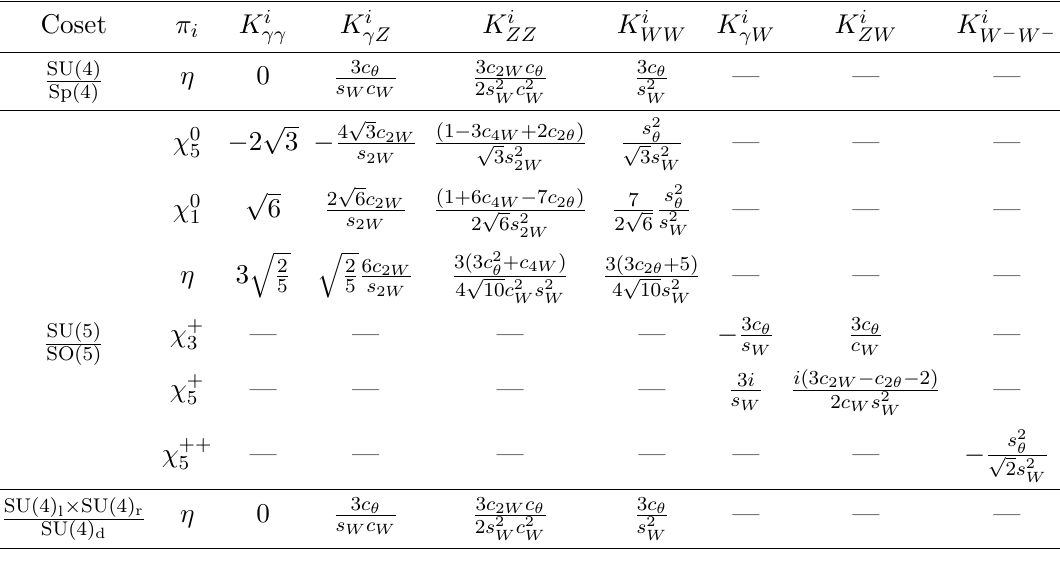
Table 1 . Coefficients of the anomaly terms in eq. (2.7) uniformly normalized by a factor e 2 dim( ψ ) Here η always denotes a SM singlet while the remaining coefficients are expressed in the custodial basis but otherwise agree with those in [10]. The pNGBs not appearing in the table do not couple to the anomaly